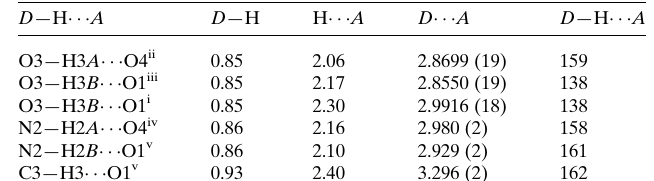
Table 1 Hydrogen-bond geometry (A˚ , (cid:3) ).